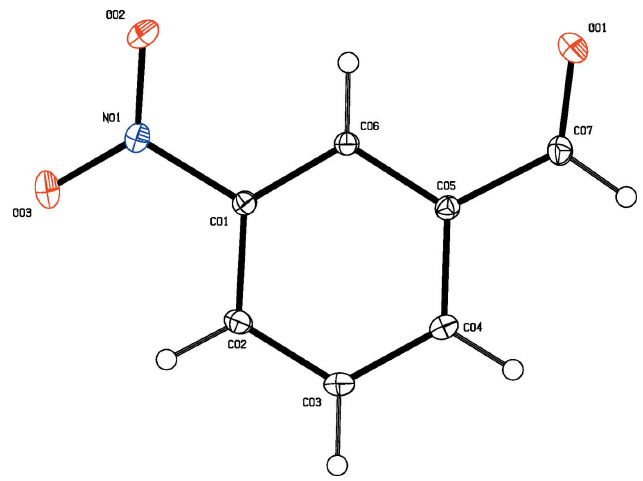
Figure 1 The molecular structure of the title compound, showing displacement ellipsoids drawn at the 30% probability